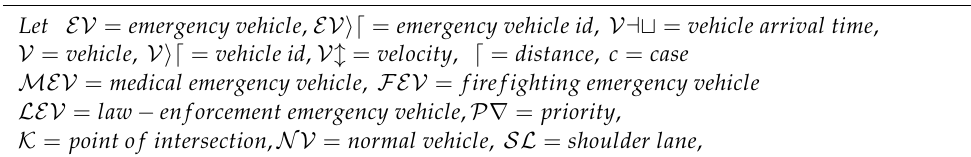
Algorithm 1. Passing of EV with varying priority from